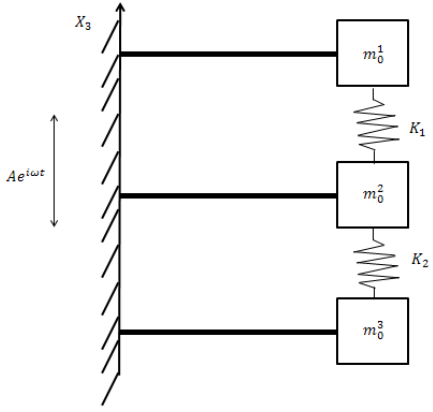
Figure 1. Three bimorphs interconnected by springs—the present harvester design.